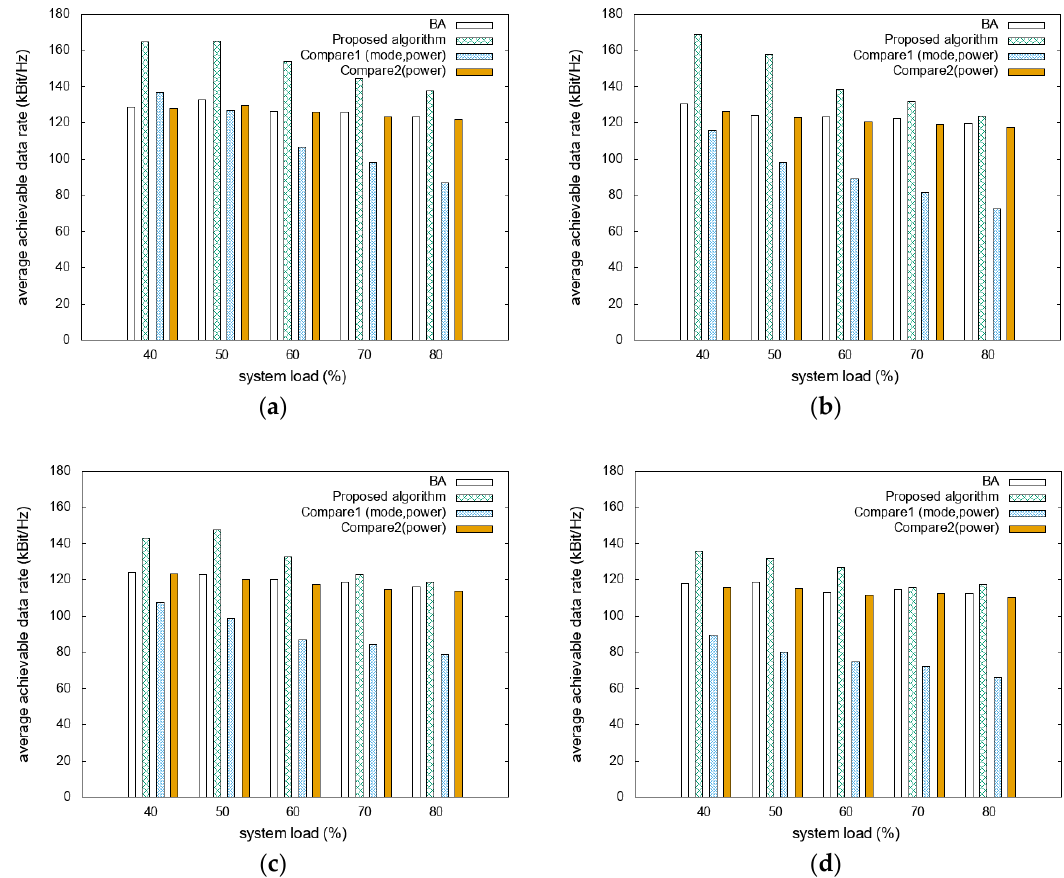
Figure 4. Comparison of average achievable data rate with various D2D distances and system loads: ( a ) 250 m with light traffic; ( b ) 350 m with light traffic; ( c ) 250 m with heavy traffic; and ( d ) 350 m with heavy traffic.